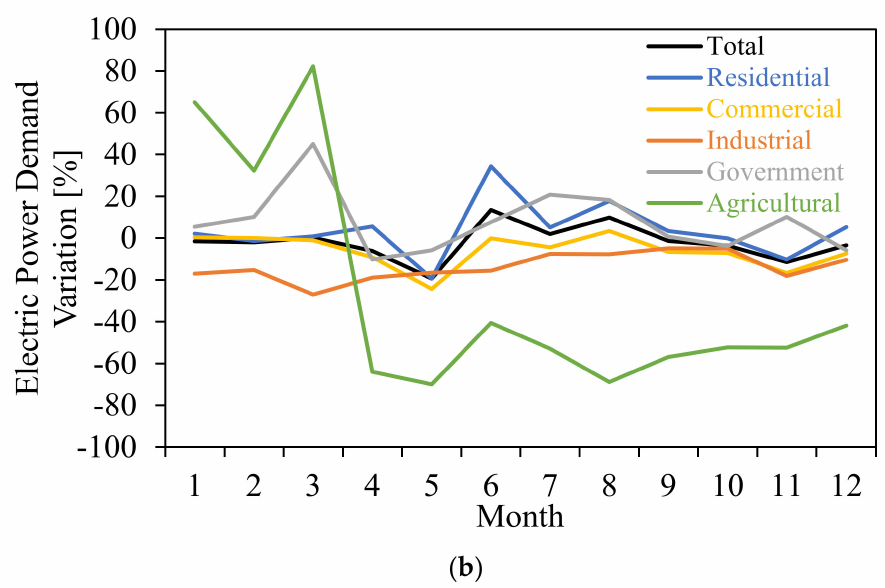
Figure 10. Monthly change of the electric power demand in 2020 from ( a ) a billable and ( b ) a percentage analysis relative to the average demand at a given